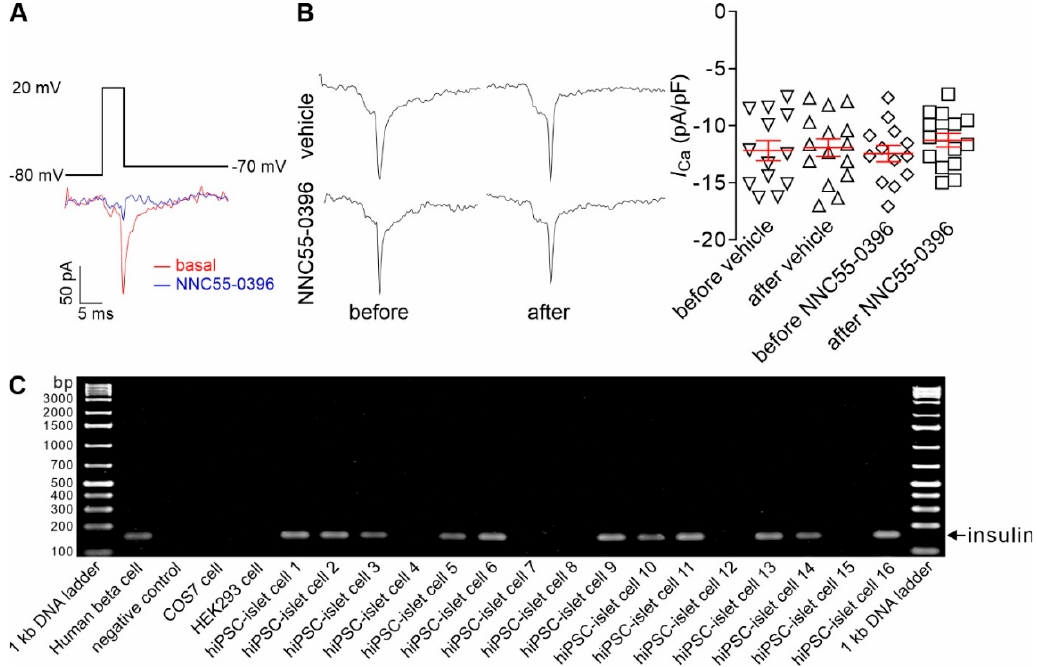
Figure 3. Effects of intravitreal infusion of NNC55-0396 on Ca V 3 currents in insulin-expressing cells of retrieved intraocular hiPSC-islet grafts. ( A ) Slow deactivating tail current traces evoked by a depolarizing voltage pulse from − 80 mV to +20 mV for 5 ms back to − 70 mV ( upper panel ) in an insulin-positive cell of intraocular hiPSC-islet grafts retrieved at 2 months post-transplantation before (red) and when exposed to NNC55-0396 during patch clamp recordings (blue). ( B ) Sample slow deactivating tail current traces ( left ) and quantification of the average density of slow deactivating tail currents ( right ) registered in insulin-positive cells of intraocular hiPSC-islet grafts retrieved at 2 months post-transplantation following intravitreal infusion of vehicle or NNC55-0396; n = 13 for group before intravitreal infusion of vehicle (before vehicle), n = 15 for group after intravitreal infusion of vehicle (after vehicle), n = 13 for group before intravitreal infusion of NNC55-0396 (before NNC55-0396) and n = 15 for group after intravitreal infusion of NNC55-0396 (after NNC55-0396). ( C ) RT-PCR analysis of cDNA generated by reverse transcription of mRNA in insulin-positive cells of intraocular hiPSC-islet grafts retrieved after patch clamp recordings as well as a human islet β cell, negative control (sterile ultrapure water), COS7 cell and HEK293 cell with specific primers for insulin (146 bp amplicon).